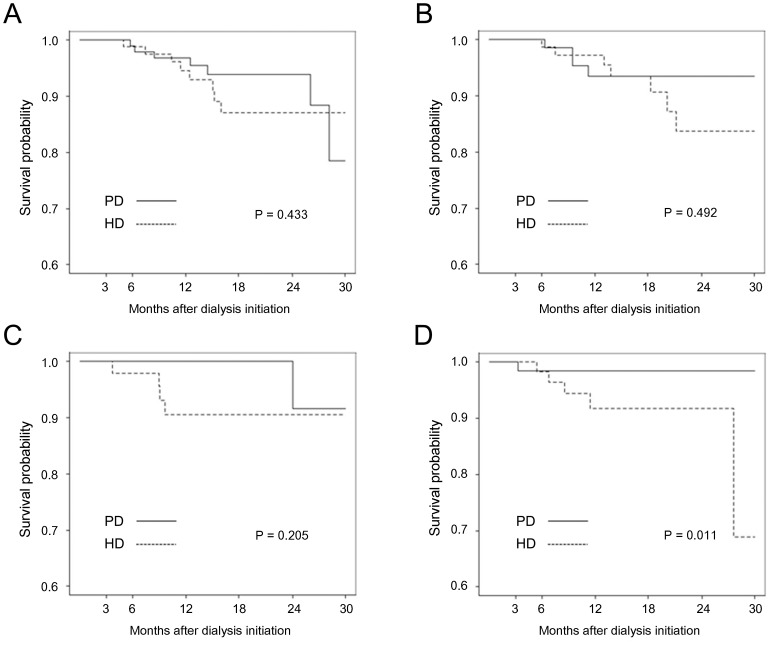
Kaplan-Meier curve according to sex and presence of diabetes in propensity-score matched population.(A) diabetic male; (B) non-diabetic male; (C) diabetic female; (D) non-diabetic female A Male, DM B Male, non-DM C Female, DM D Female, non-DM.